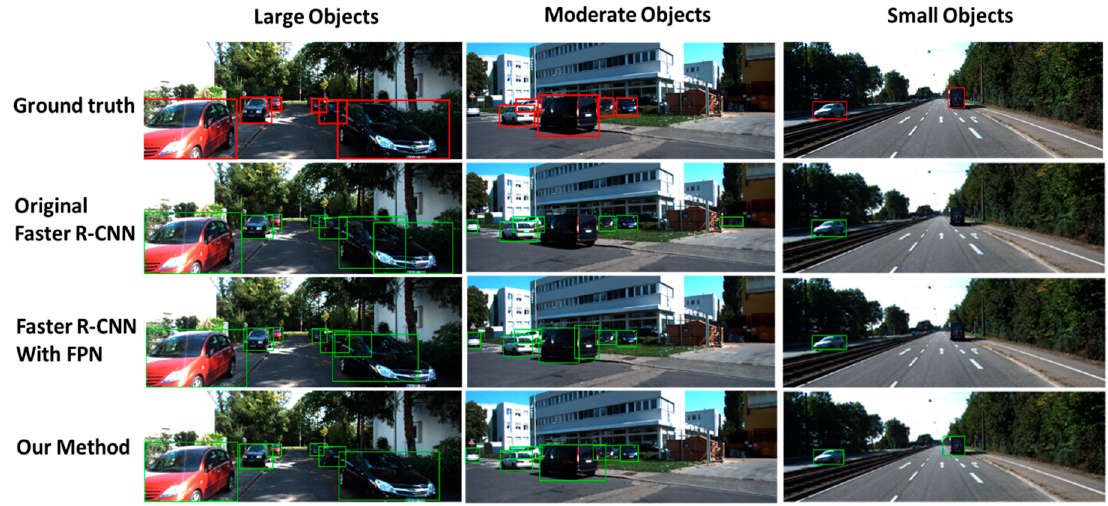
Figure 9. Some examples of the detection results of different vehicle detectors on Kitti.